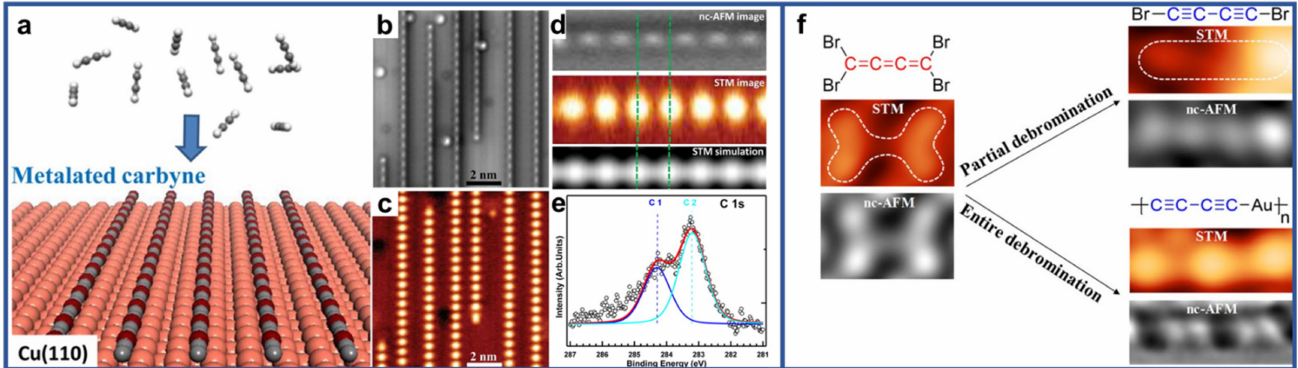
Figure 4. ( a – d ) On-surface synthesis of organometallic carbon chains by dehydrogenative coupling of ethyne molecules on a Cu(110) surface. Reprinted with permission from Ref. [55]. ( e ) C 1s core- level XP spectrum showing the major peak C2 located at a binding energy of 283.2 eV (cyan curve). Copyright 2016, American Chemical Society. ( f ) On-surface synthesis of organometallic carbon chains by entire debromination of C 4 Br 4 molecules followed by homocoupling on Au(111) surface and the transformation from cumulene to diyne moiety via partial debromination induced by STM tip. Reprinted with permission from Ref. [56]. Copyright 2020, American Chemical